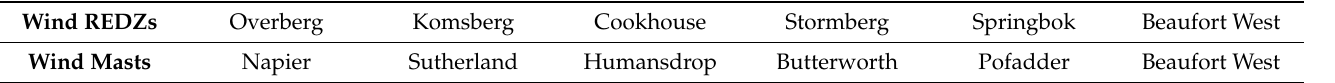
Table 2. Wind REDZs with corresponding wind masts. Table 2. 180